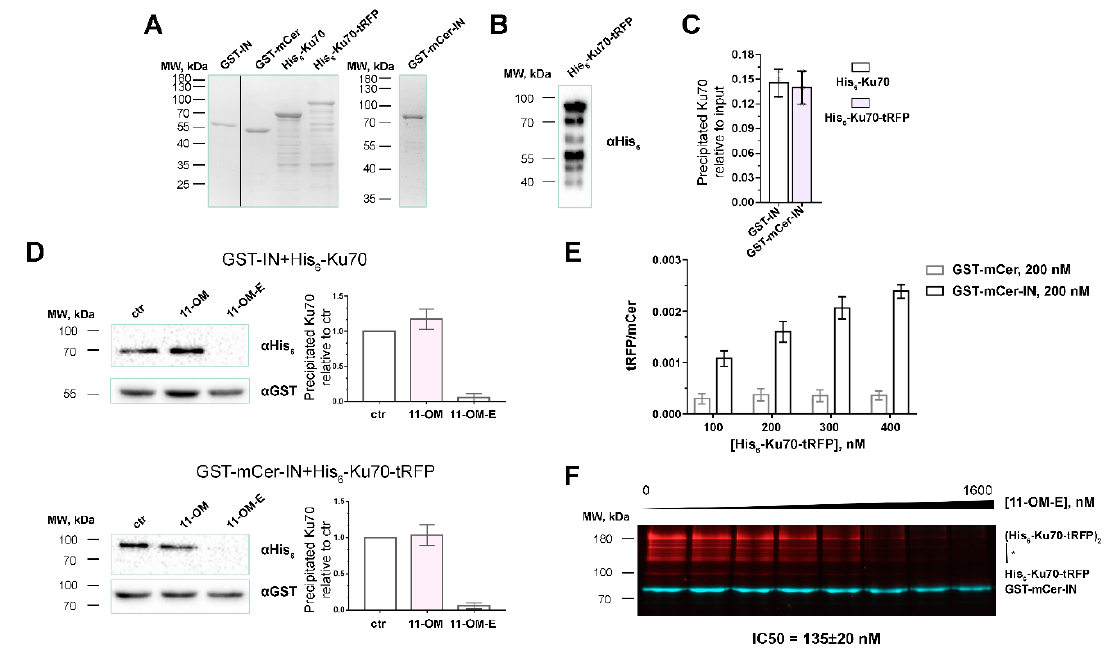
Figure 2. Validation of the fluorescent assay for the discovery of Ku70-IN inhibitors. ( A ) SDS-PAGE analysis of recombinant proteins GST-IN, GST-mCer, GST-mCer-IN, His 6 -Ku70, His 6 -Ku70-tRFP. ( B ) Western-blot analysis of His 6 -Ku70-tRFP purity using an anti-His 6 antibody. ( C ) GST-mCer-IN (200 nM) binds His 6 -Ku70-tRFP (200 nM) at the same amount as GST-IN (200 nM) binds His 6 -Ku70 (200 nM). ( D ) Interaction of 200nM GST-IN and His 6 -Ku70 or GST-mCer-IN and His 6 -Ku70-tRFP in the absence or in the presence of well-characterized inhibitor 11-OM-E (1 µ M) or control compound 11-OM (1 µ M) is analyzed by GST-pull-down assay with subsequent WB analysis against GST and His 6 -tags. ctr–control, binding of proteins in absence of 11-OM-E or 11-OM. ( E ) Precipitation of His 6 -Ku70-tRFP with GST-mCer-IN or GST-mCer analyzed by the method described here in 96-well plate format. ( F ) Fluorescent pull-down assay analysis of the interaction of His 6 -Ku70-tRFP (200nM) and GST-mCer-IN (200 nM) in the presence of an increasing concentration of 11-OM-E. * signed dimers of the full-length His 6 -Ku70-tRFP and N-terminal degraded forms.